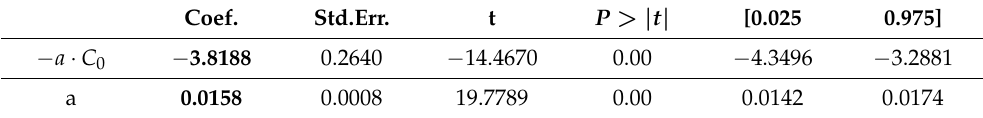
Table 3. Estimation of constant absorption parameters with measured data from 1950 to 2000.